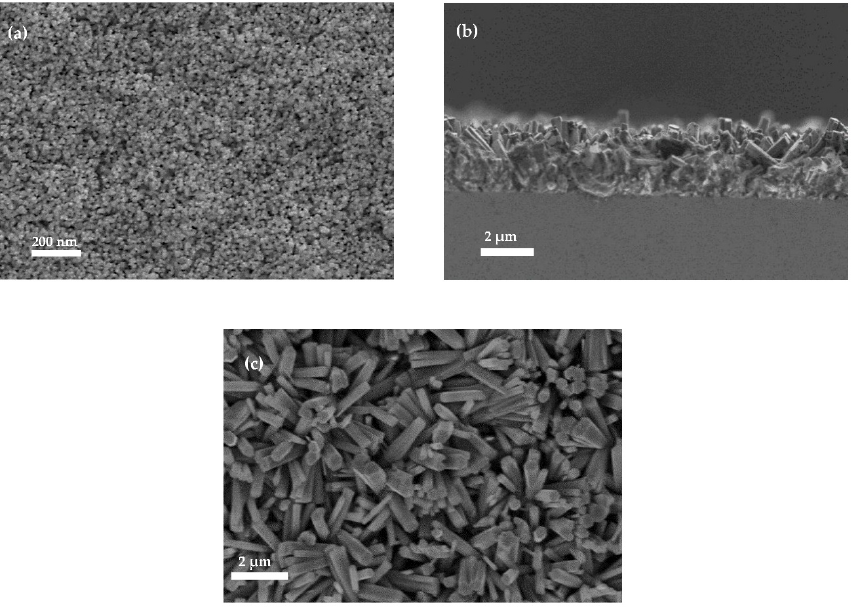
Figure 10. ( a ) Top view of the optimized ZnO emitter (391 nm thickness), ( b ) SEM cross-section view showing the NRs-ZnO/n-ZnO/p-GaAs heterojunction, and ( c ) top view of the grown ZnO nanorods (NRs ZnO).